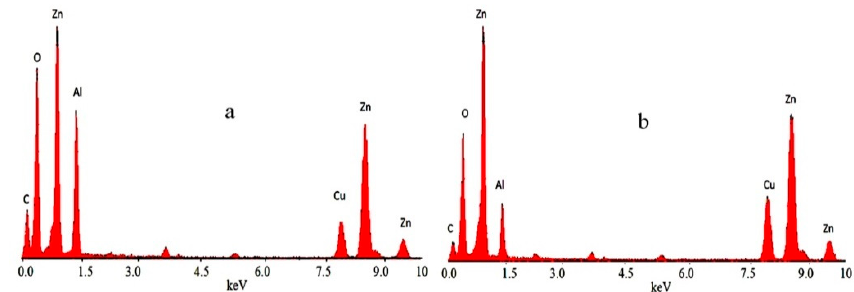
Figure 5. Energy-dispersive X-ray (EDX) spectra of ( a ) nanohybrid NH1 and ( b ) nanohybrid NH3.